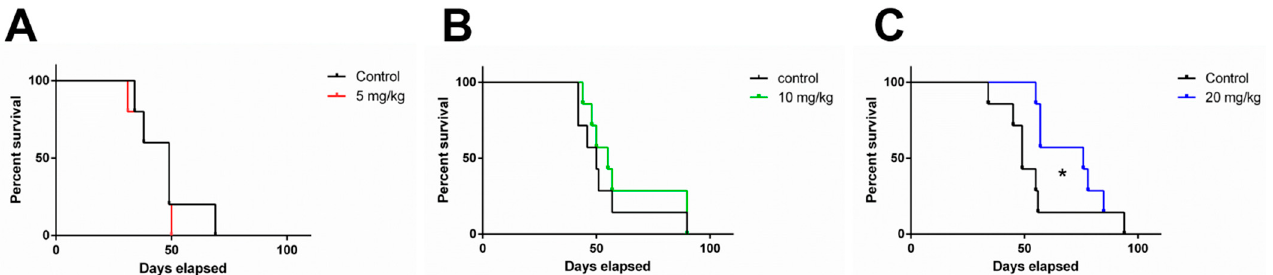
Figure 4. Glioma-bearing nude mice treated with different i.p daily doses of 1A-116. Survival curves of nude mice treated with vehicle or 1A-116 are shown. ( A ) 5 mg/kg/day 1A-116 daily treatment did not show differences compared to control group (n = 5 in each group). ( B ) 10 mg/kg/day 1A-116 treatment show a non-significant increase in median survival (n = 7 in each group). A representative experiment of two independent experiments is shown. ( C ) 20 mg/kg/day 1A-116 significantly in- creased mice survival compared to control group (n = 7, Mantel–Cox log-rank Test, * p < 0.05). A representative experiment of two independent experiments is shown.